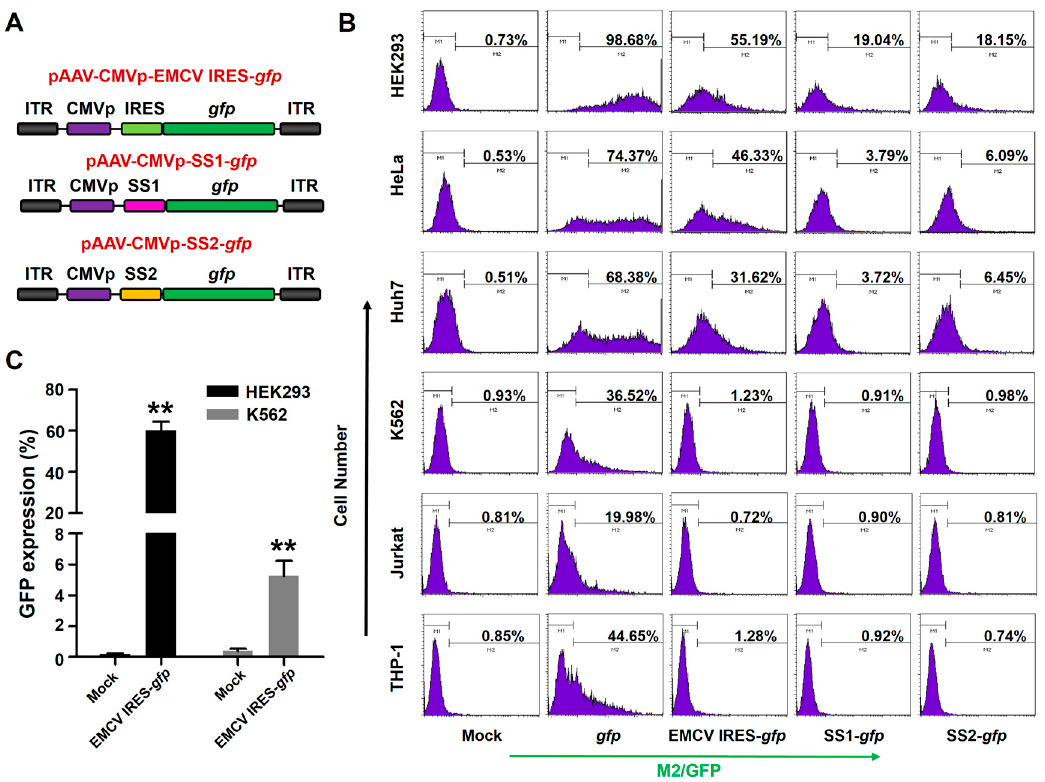
Figure 3. The effect of EMCV IRES on various cell types. ( A) Diagram of the rAAV6 vector genomes. (B) Indicated cells were transduced with indicated rAAV6 vectors at 10,000 vgs/cell. Transgene expression was detected by flow cytometry at 72 hours post-transduction. (C) HEK293 and K562 cells were infected with LV-CMVp-EMCV IRES- gfp using lentiviral supernatant. Transgene expression was detected by flow cytometry at 7 days post-infection.